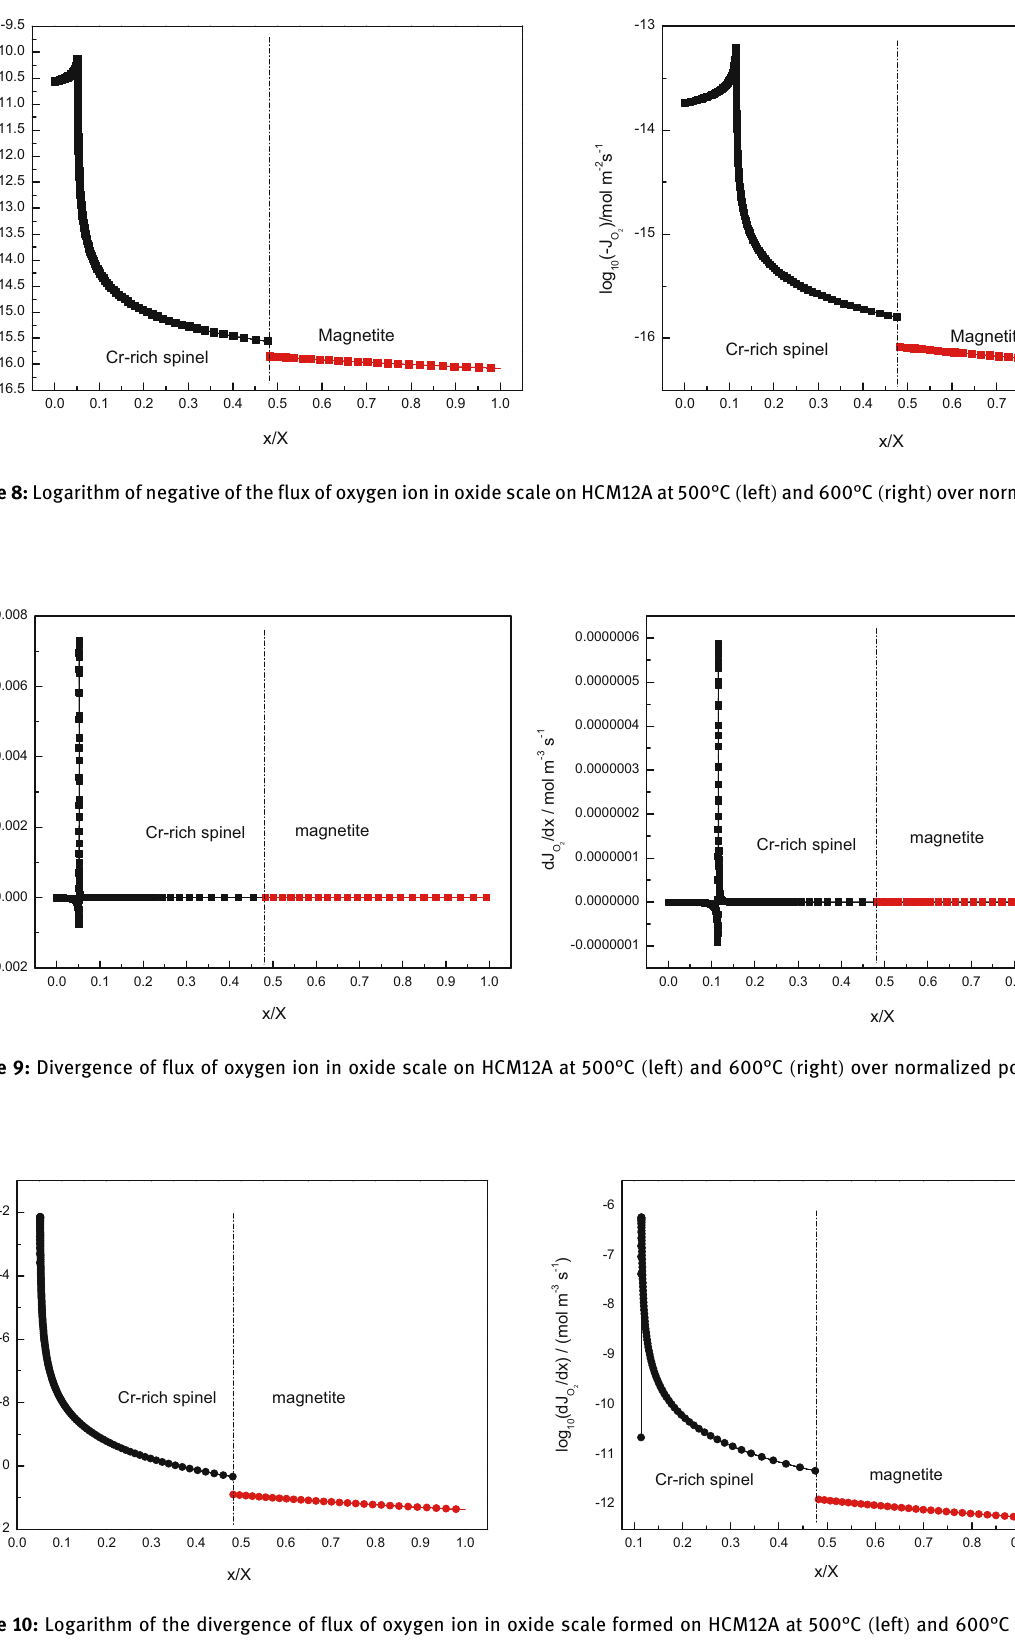
Figure 10: Logarithm of the divergence of flux of oxygen ion in oxide scale formed on HCM12A at 500°C ( left ) and 600°C ( right ) over normalized